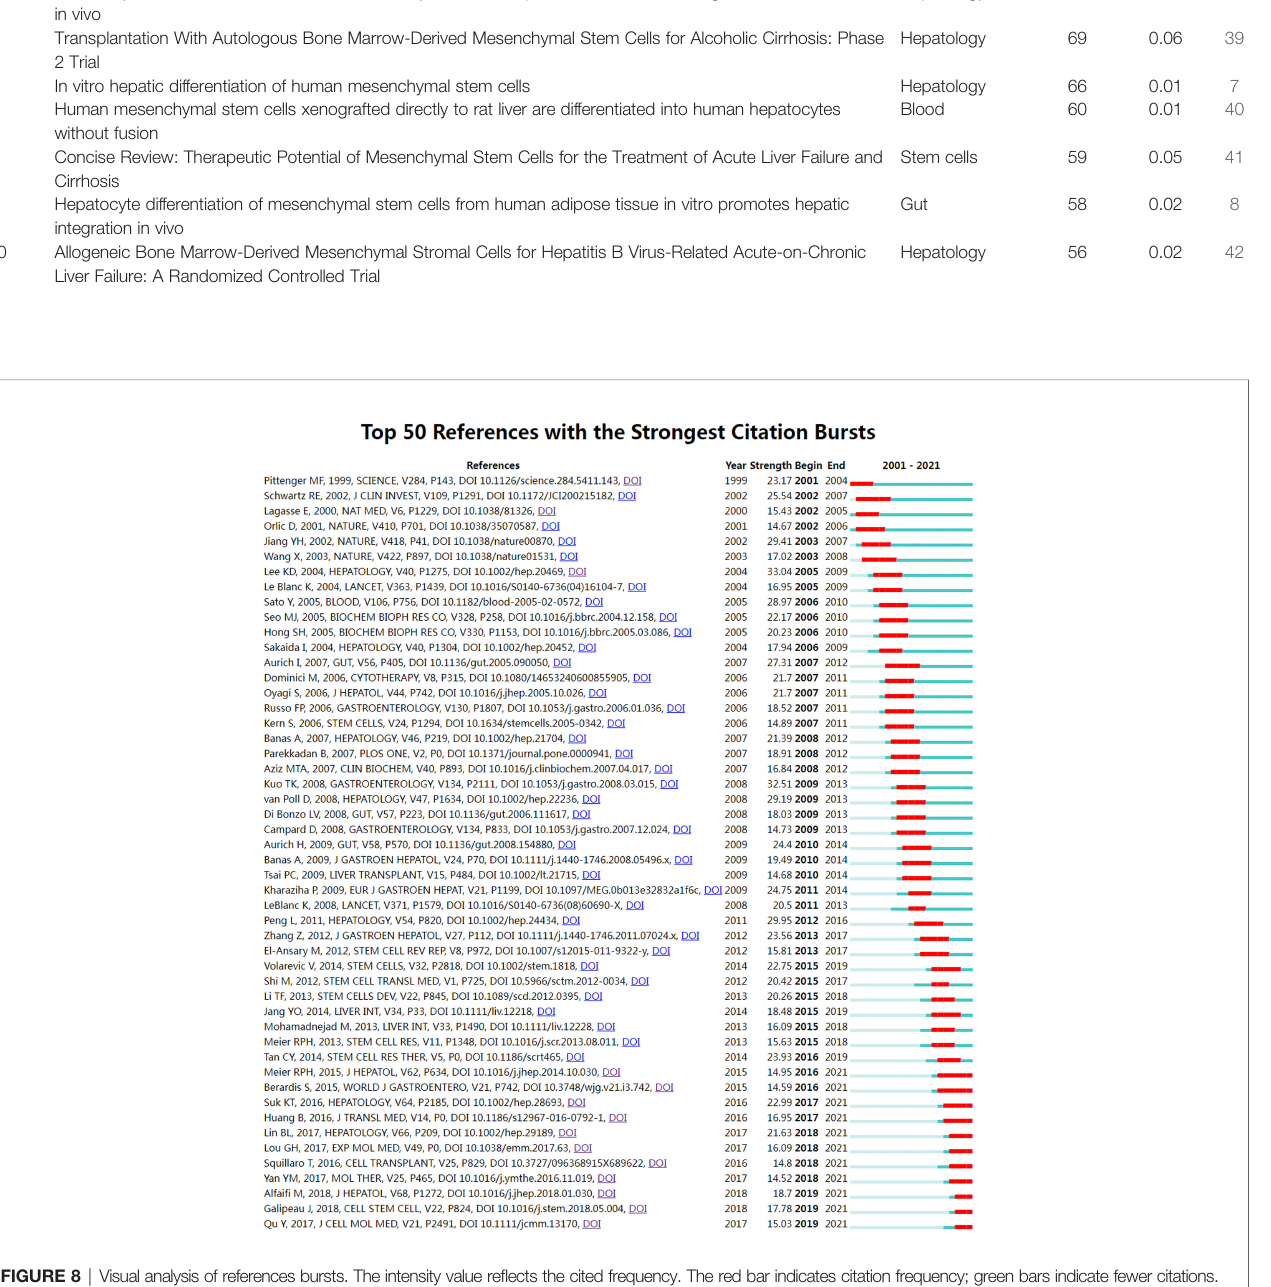
FIGURE 8 | Visual analysis of references bursts. The intensity value re fl ects the cited frequency. The red bar indicates citation frequency; green bars indicate fewer